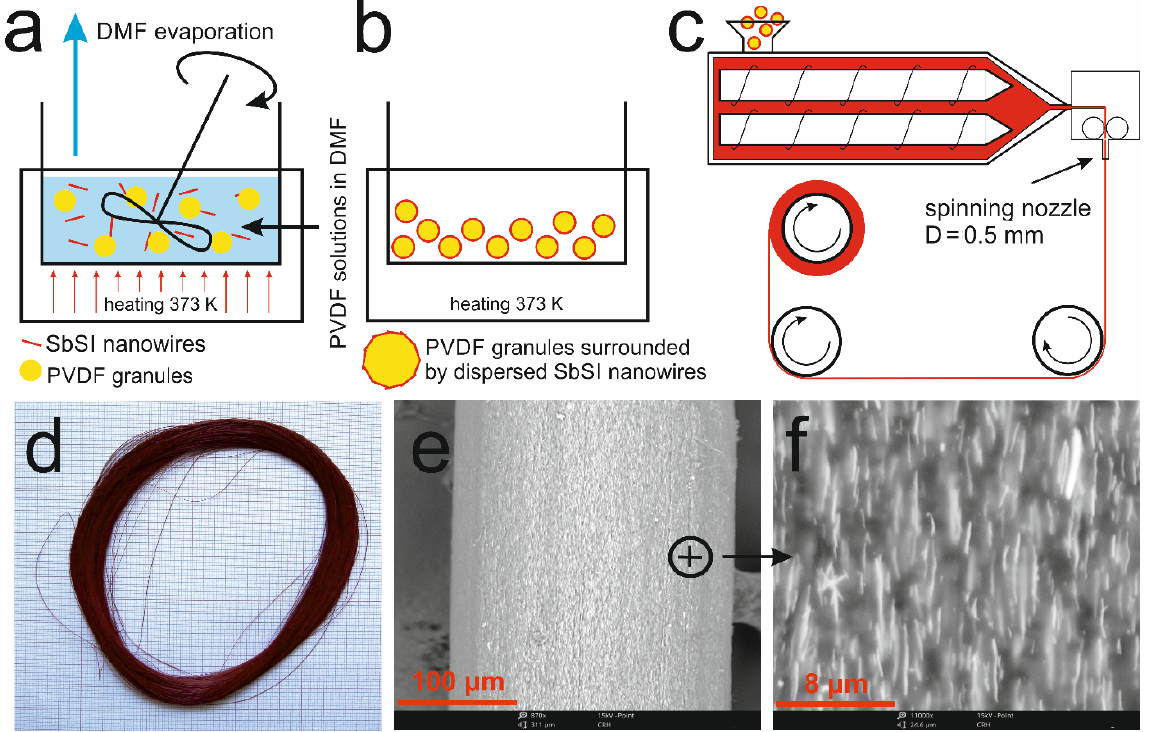
Figure 8. Images depicting the preparation scheme for PVDF/SbSI fibres. ( a ) Evaporation of DMF after the homogeneous suspension of the SbSI wires is obtained and an adding of 80 g of PVDF granules. ( b ) The obtained PVDF granules are covered by dispersed SbSI nanowires. ( c ) The twin-screw extruder that is used to form the fibres. ( d ) Photograph of the obtained PVDF/SbSI fiber for the case where the collection velocity is 200 m/s. ( e , f ) SEM images showing the fibre presented in Figure 8d.